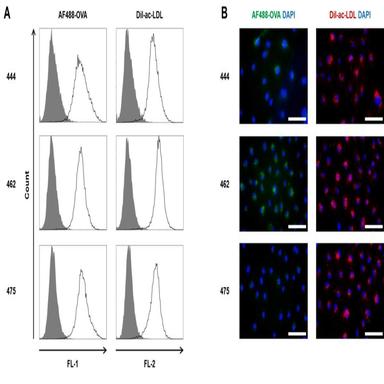
upcyte® LSECs feature receptor-mediated endocytosis of conjugated MMR and SR ligands. Cells incubated in medium deprived of serum and cytokines, were treated with 10 µg/mL AF488-OVA or Dil-ac-LDL for 1 h, fixed with PFA and analysed by flow cytometry or fluorescence microscopy. (A) Flow cytometric analysis showing histograms of control cells without ligand (grey, filled) versus treated cells (black outline). (B) Pictures of fluorescence microscopy analysis of AF488-OVA (green) or Dil-ac-LDL (red) uptake. Nu